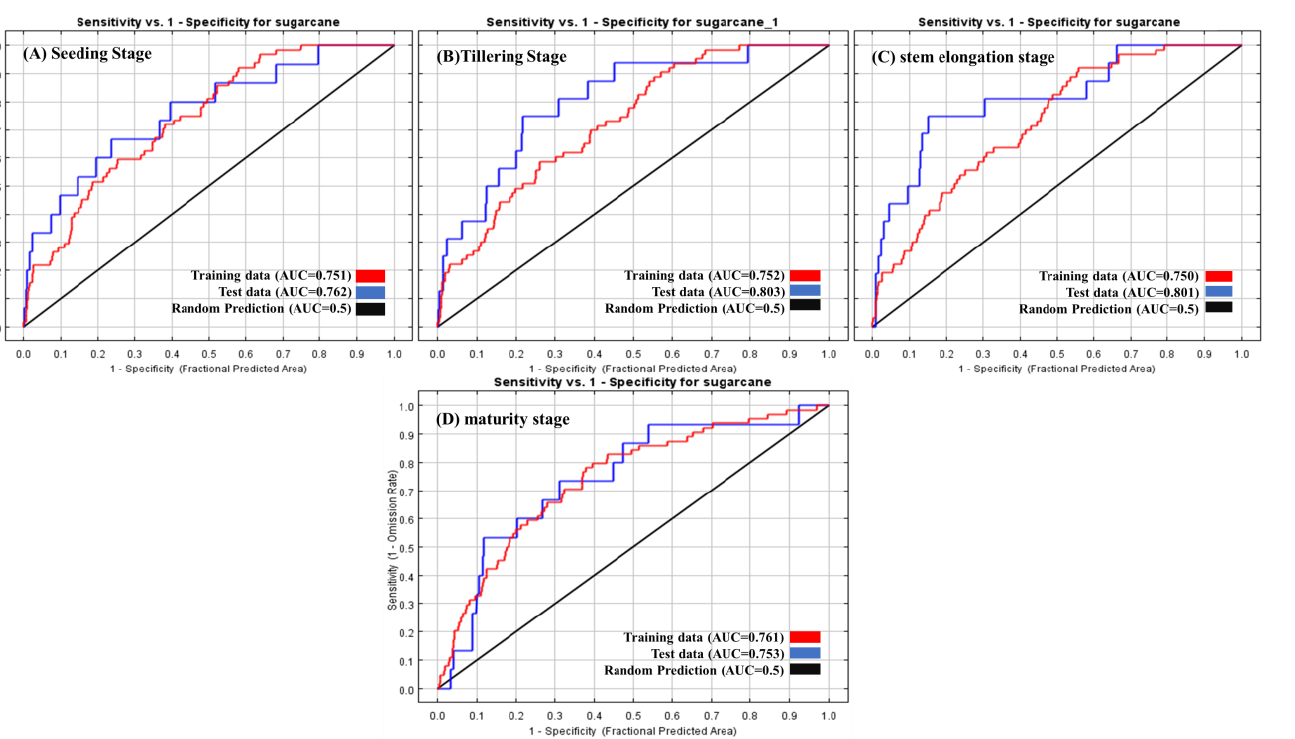
Figure 3. Receiver Operation Characteristic (ROC) curve of the MaxEnt model in the four growth stages of sugarcane. ( A – D ) refer to the growth stages of seeding emergence, tillering, stem elongation, and maturity, respectively.